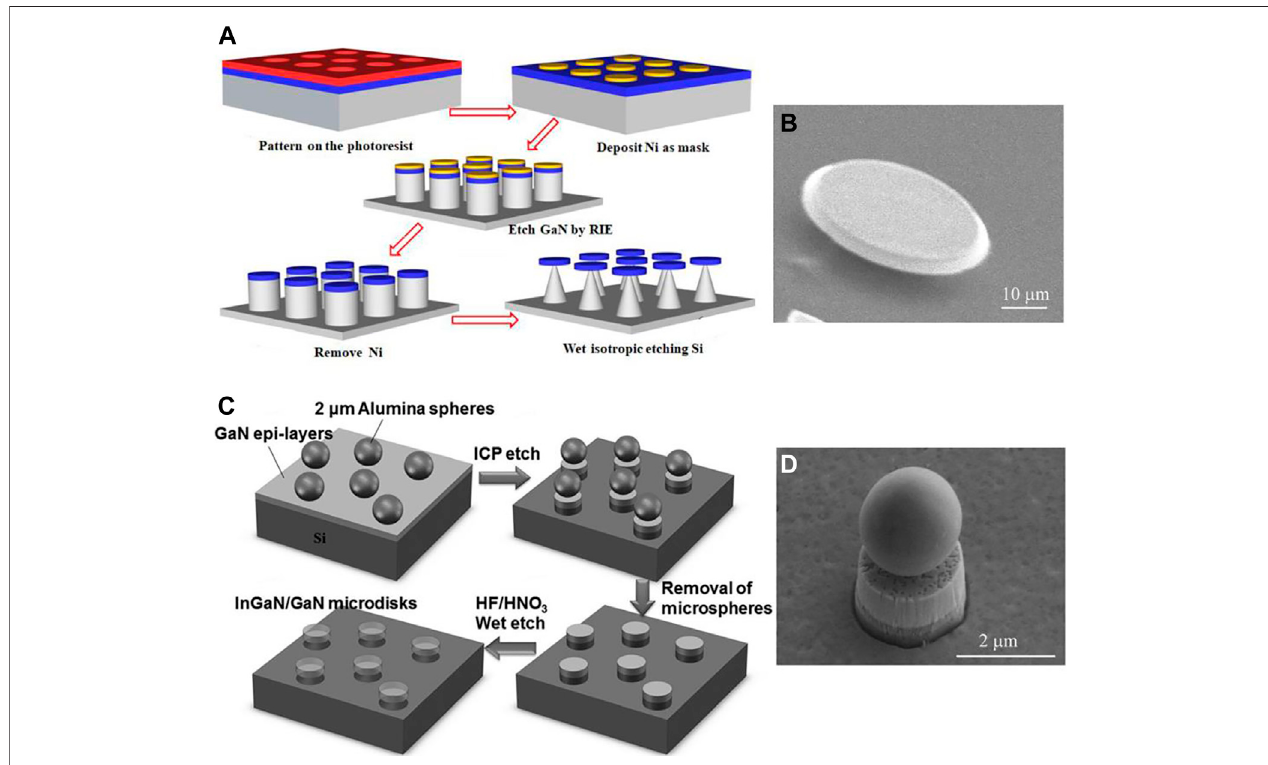
FIGURE 2 | Schematic of fabrication of GaN microdisks with (A) an Ni hard mask and (C) a sphere metal mask. SEM images of the (B) fl oated GaN microdisk fabricated by the Ni hard mask (Zhu et al., 2018), reprinted with permission © Optical Society of America (Zhu et al., 2018), and (D) GaN microdisk fabricated with the sphere mask (Zhang Y. et al., 2014), reprinted with permission © AIP Publishing LLC (Zhang Y. et al., 2014).